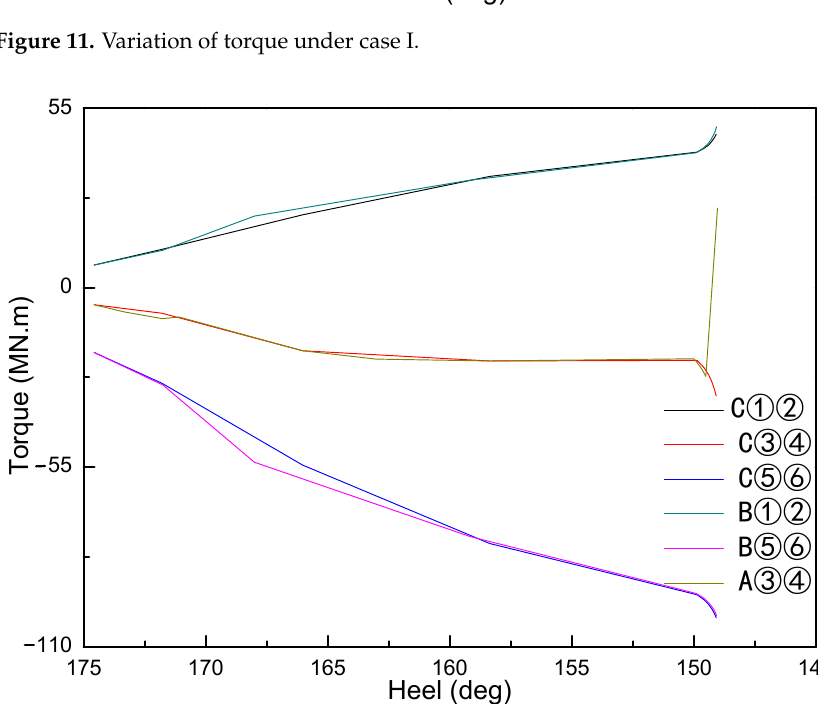
Figure 12. Variation of torque under case II.